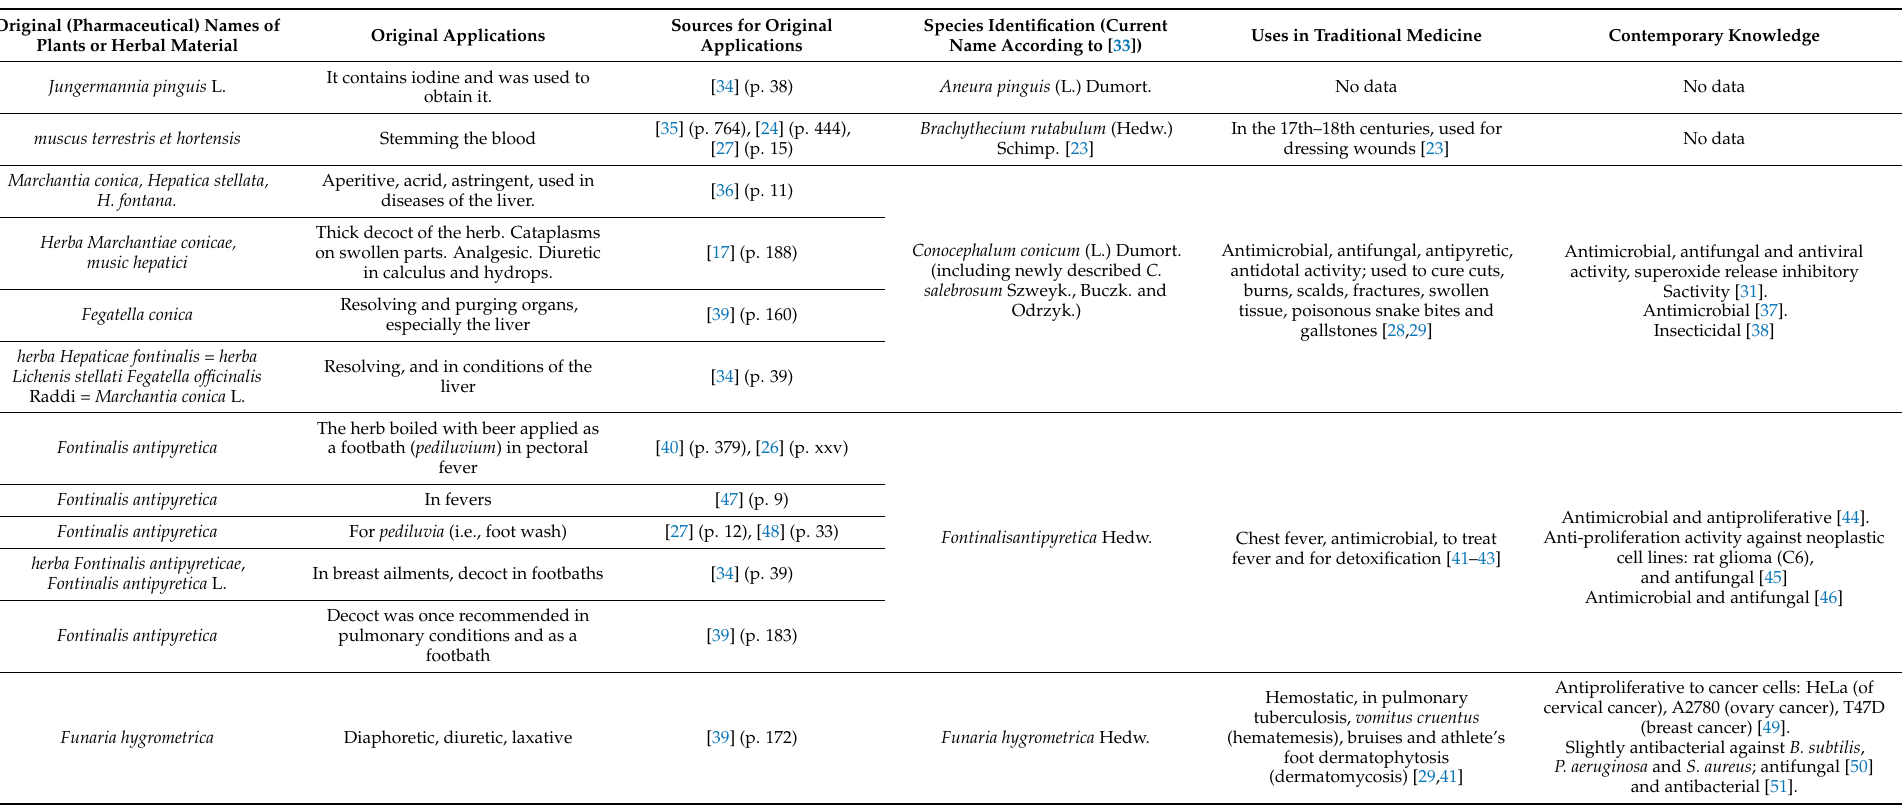
Table 1. Historical medicinal bryophytes, their taxonomical identification, ethnopharmaceutical uses and confirmed medicinal